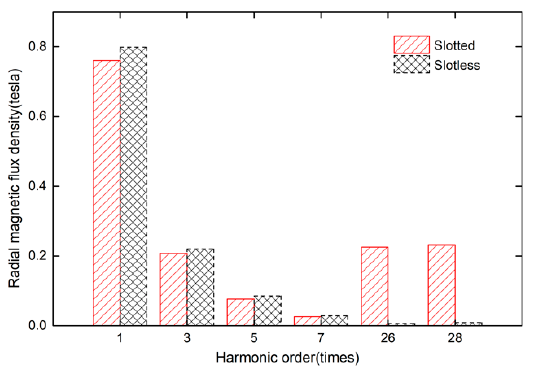
no-load airgap magnetic density in Figure 3. There are 54 stator slots, and the number of poles is 4 for the motor model.